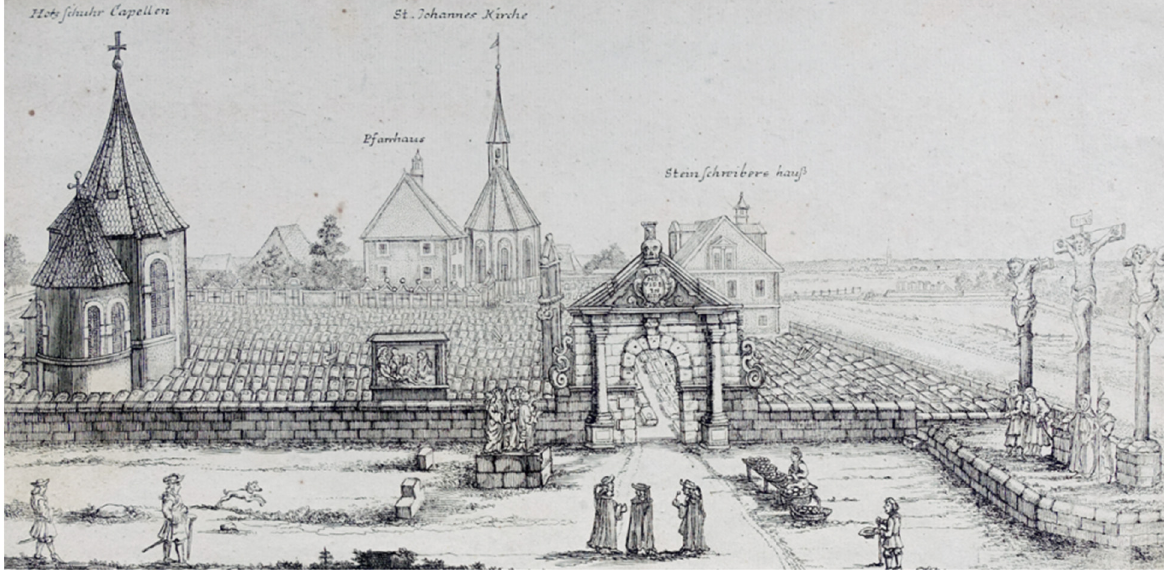
Figure 22. Johann Alexander Boener, St. John’s Cemetery, Nuremberg , engraving, ca. 1700.